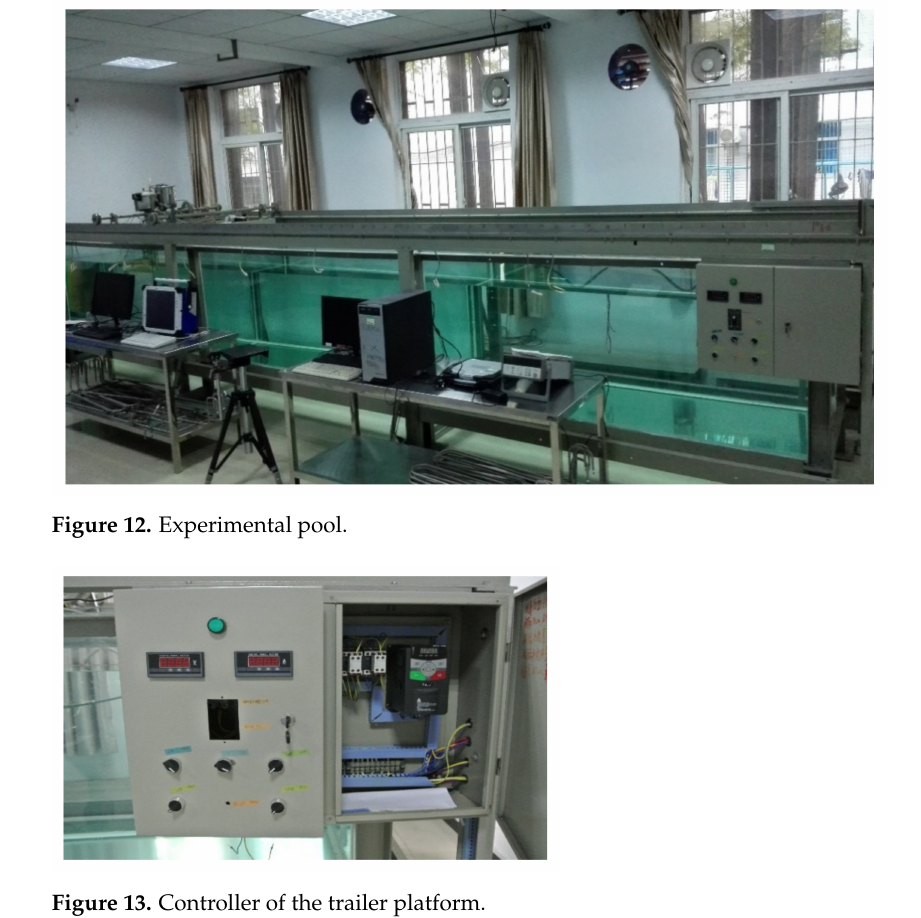
Figure 13. Controller of the trailer platform.